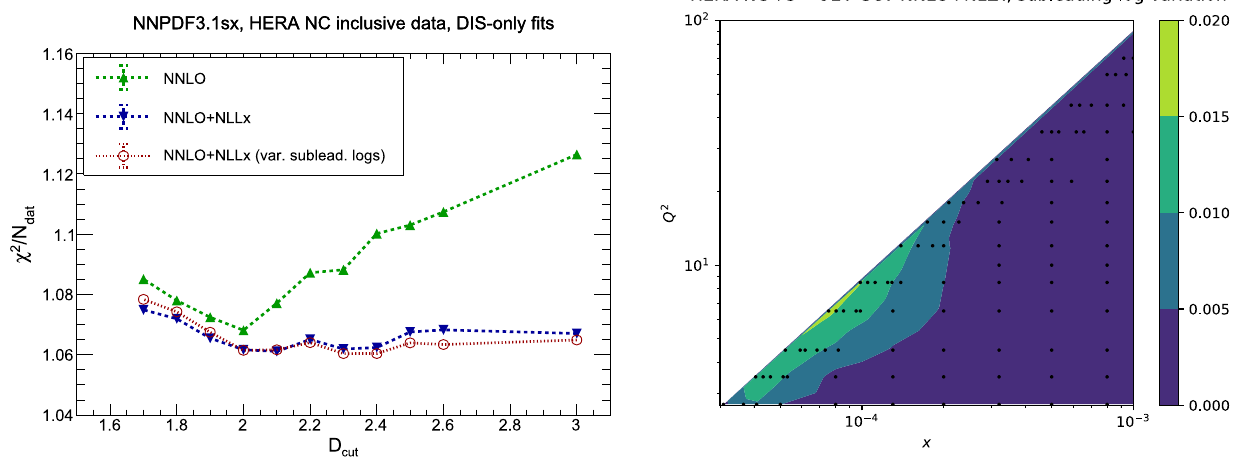
Fig. 27 Left panel: the values of χ 2 / N dat in the NNPDF3.1sx DIS- only fits for the HERA NC inclusive structure function data for different values ofthecut D cut Eq.(5.2), comparedtotheresultsofafitwherethe subleading logarithms are varied. Right panel: same as Fig. 26, now for